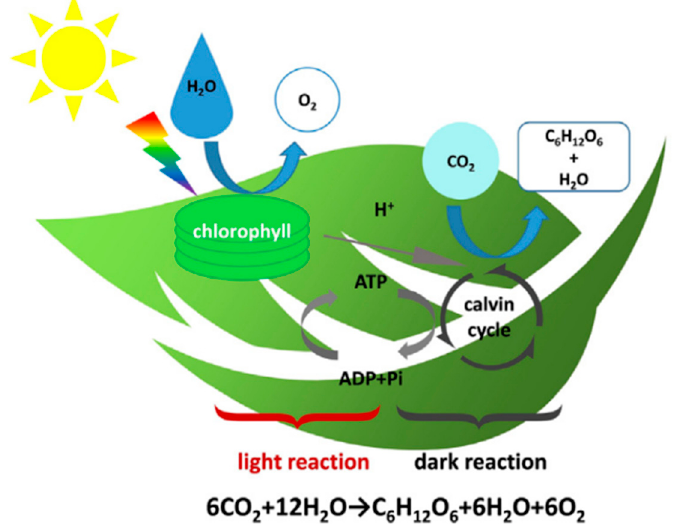
Figure 25. A schematic illustration of photosynthesis [176]. Copyright 2018, Elsevier.